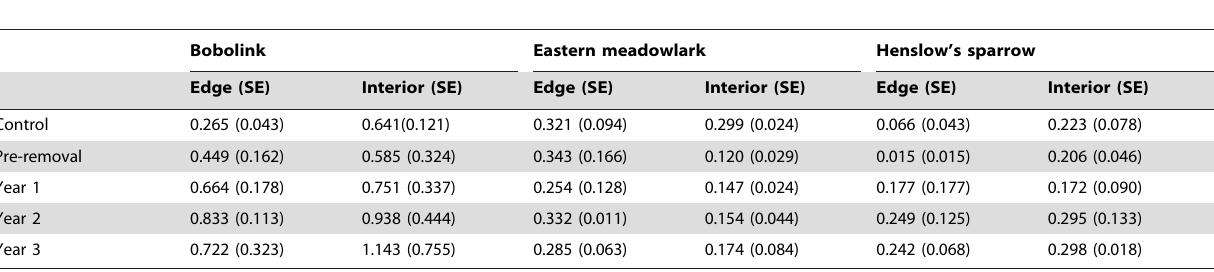
Table 1. Mean male density (males/ha) and standard errors (in parentheses) for obligate grassland birds in tree row edge and grassland interior habitats at the control and treatment